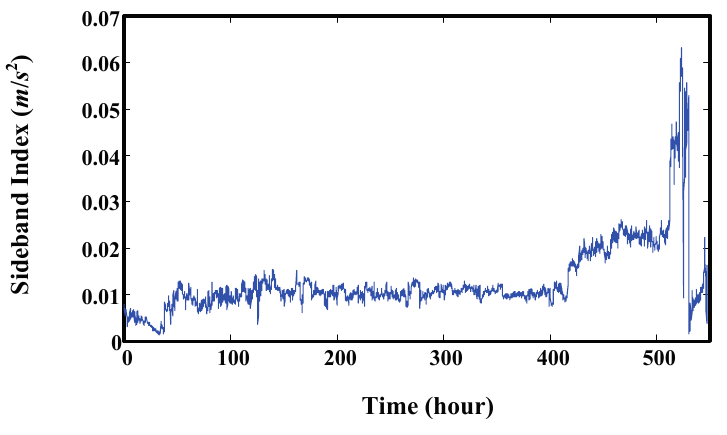
Figure 16. Sideband index developed in [31].